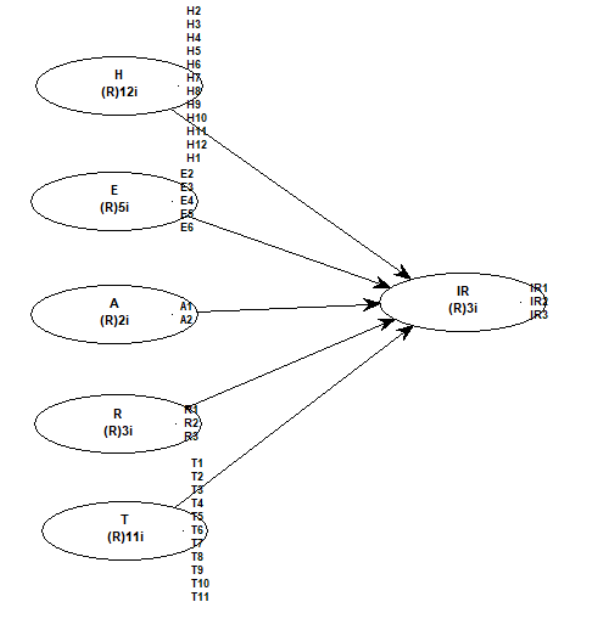
Fig. 2. Experiment Variable Model